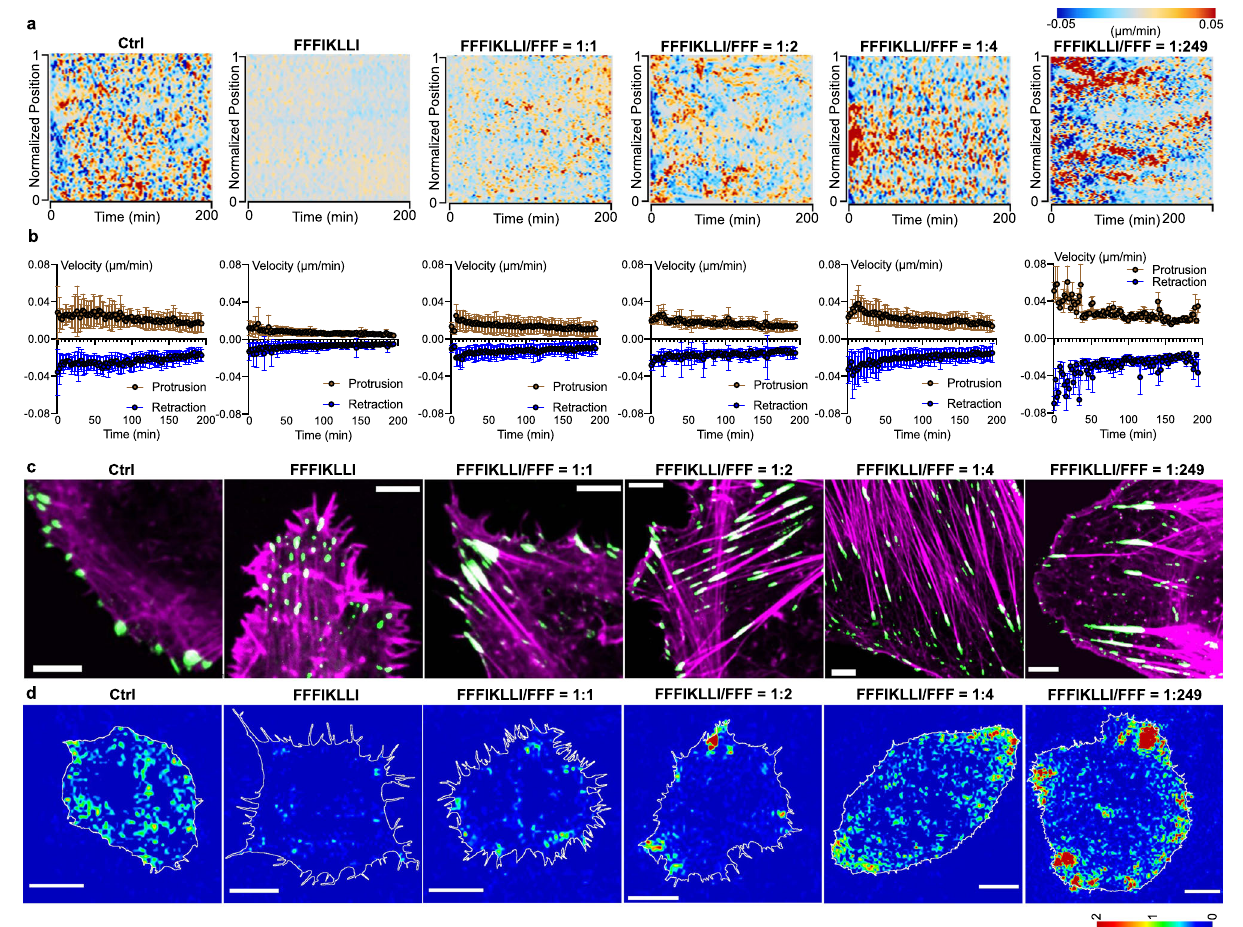
Fig. 3 | Nano fi laments regulate membrane dynamics and FAorganizationsin a liganddensitydependentmanner. Kymographofnormalizededgevelocity a and mean velocity b over time for protrusions and retractions along the entire per- iphery of HuH-7 cells, n =8, 9, 9, 9, 10, 7 cells, respectively. Data are presented as